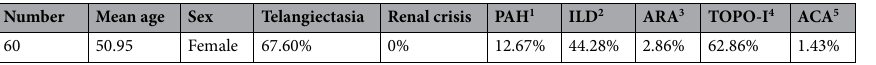
Table 1. Demographic data and representative characteristics of the patients. 1 Pulmonary hypertension, 2 Interstitial lung disease, 3 Anti-RNA polymerase III, 4 Anti-topoisomerase I, 5